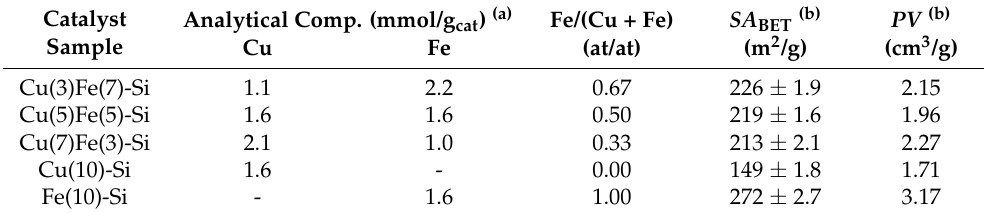
Table 1. List of catalysts, analytical composition, and textural properties.